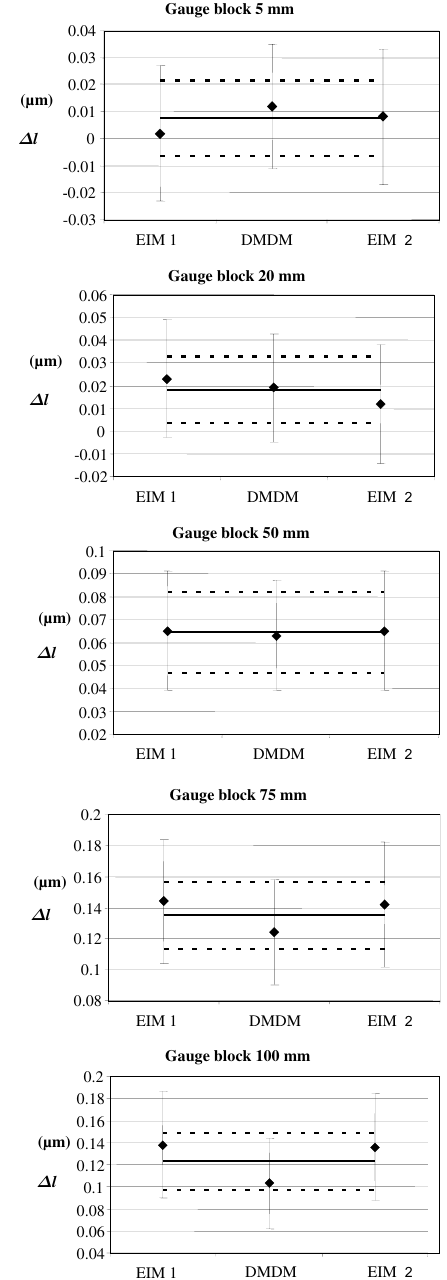
Fig. 5. Graphical presentation of the comparison results. – d = x − x Δl − Δl μ m) is the difference i ref = mean (in between measured deviation of both participants and reference deviation; – U ( d ) ( k = 2) (in μ m) is the expanded uncertainty for the difference d for ∼ 95% confidence level; – Ej = d/U ( d ) is En (Chi-squared) value that represent the degree of equivalence between the measurement results of the comparison Comparison results are shown in the graphical form in Figure 5 as